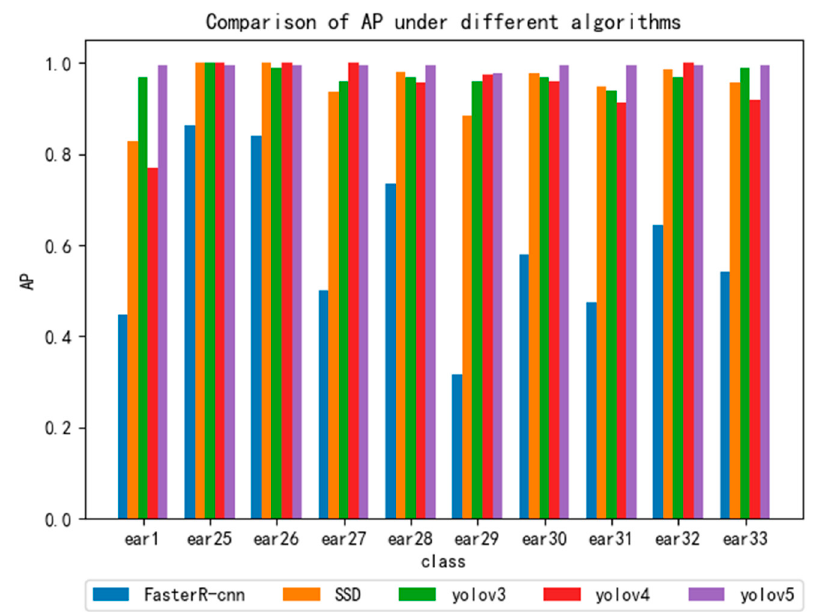
Figure 10. Comparative experiment of YOLOv3, YOLOv4, YOLOv5, SSD and Faster R-CNN models.